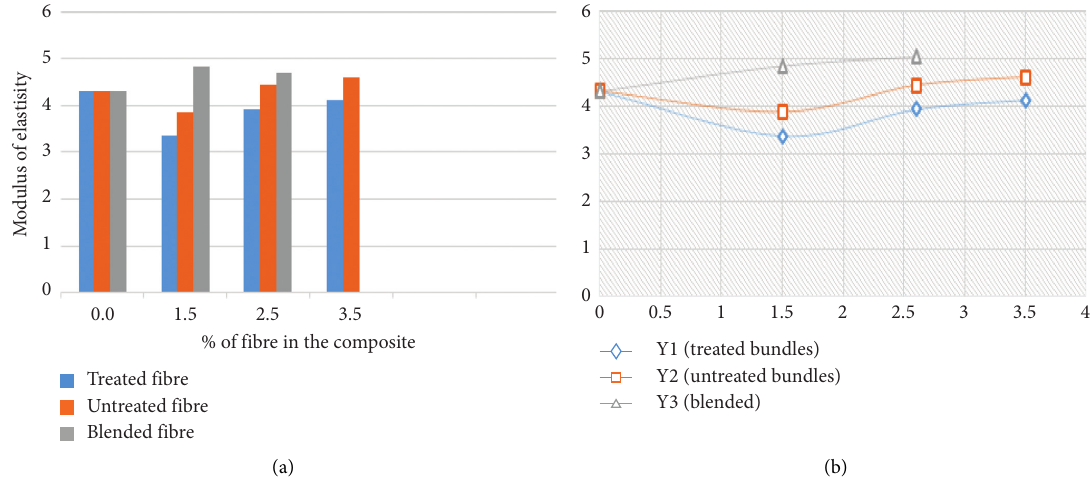
Figure 6: Modulus of elasticity of the reinforced hybrid fibre/gypsum plaster composite at different wt. % fibre dosages for different treatments.